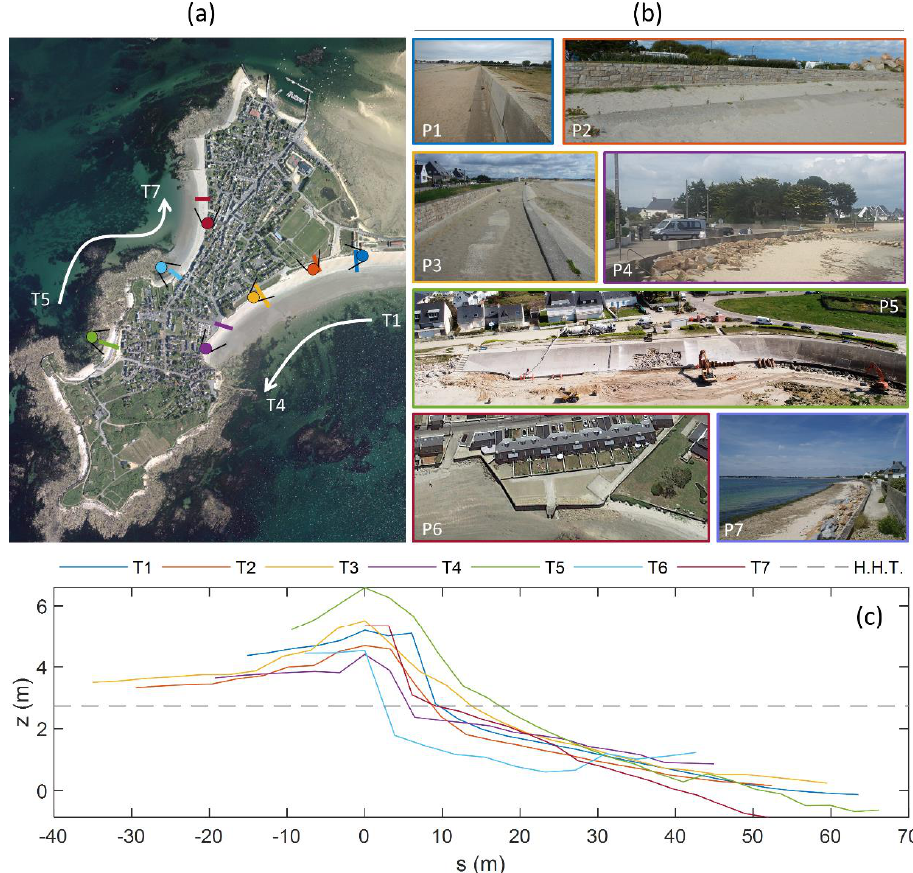
Figure 3. Aerial photo of Gâvres ( a ), local photos ( b ), and topo-bathymetric transects ( c ). ( a ): the colored circles and associated black lines indicate the location and direction of the shootings P1 to P7, the colored lines indicate the location of the transects T1 to T7, the colors of the circles and lines refer to the frame color of the local photos ( b ) and to the line color ( c ). ( c ): topo-bathymetric transects extracted from the digital elevation model “DEM2008” (see Section 2.2) with a vertical reference corresponding to the national datum IGN69. To be noted: the photos ( b ) are not contemporary of the DEM2008 (the oldest, P1, has been acquired in 2011, the other ones have been acquired in 2017 or latest). Sources of photos: IGN ( a ), BRGM ( b , P1 to P4), © FlyUp Drone ( b , P5), Google Earth ( b , P6), André C. ( b , P7).